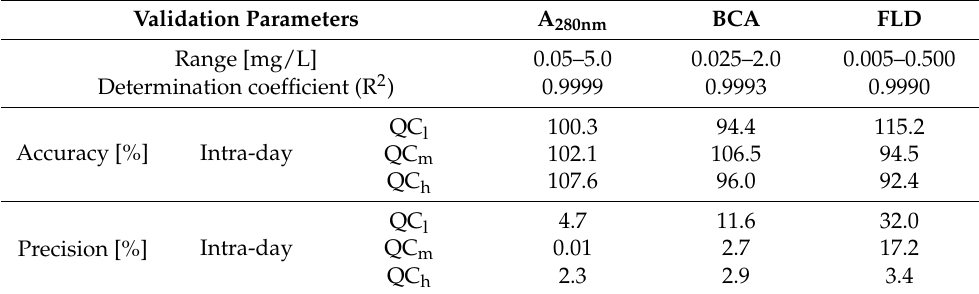
Table 4. Validation data for spectroscopic